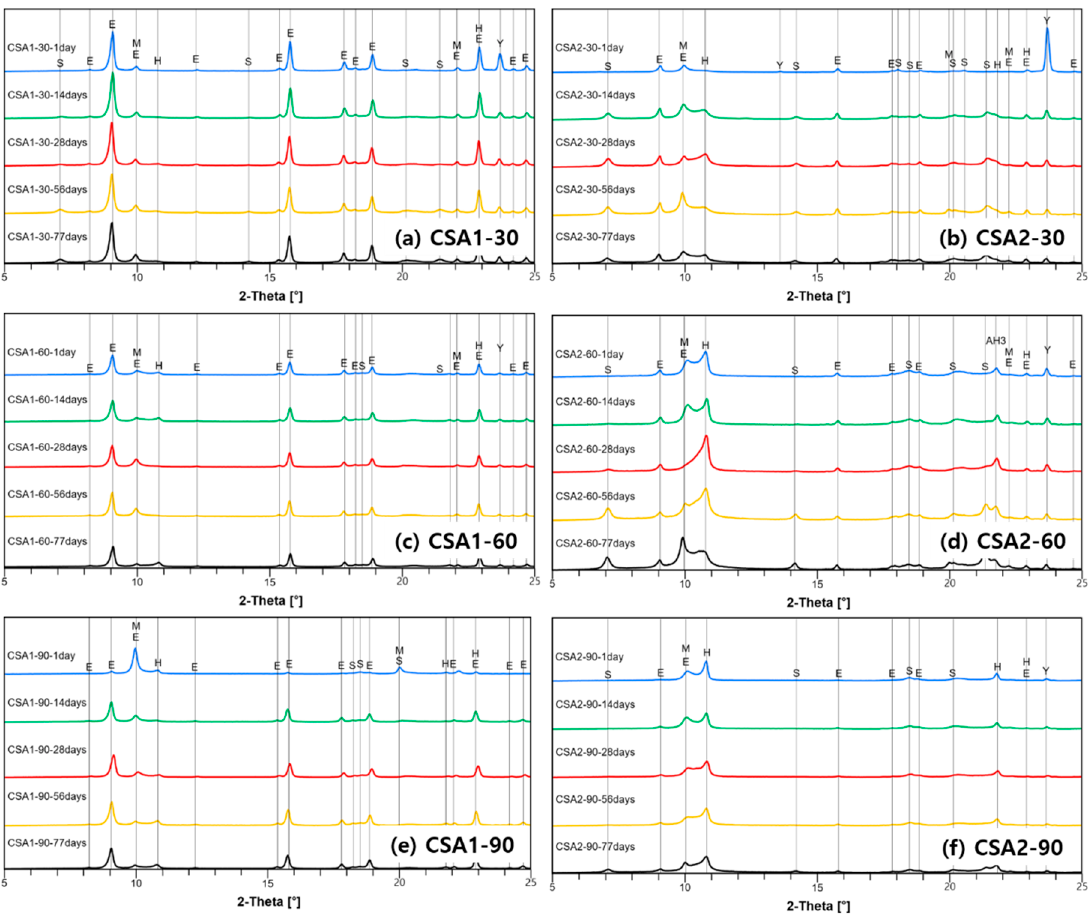
Figure 8. Measured X-ray diffraction patterns of each samples cured at ( a , b ) 30 °C, ( c , d ) 60 °C, and ( e , f ) 90 °C. Symbols of E, M, H, S, and Y indicate ettringite, monosulfate, hemicarboaluminate, and ye’elimite, respectively.